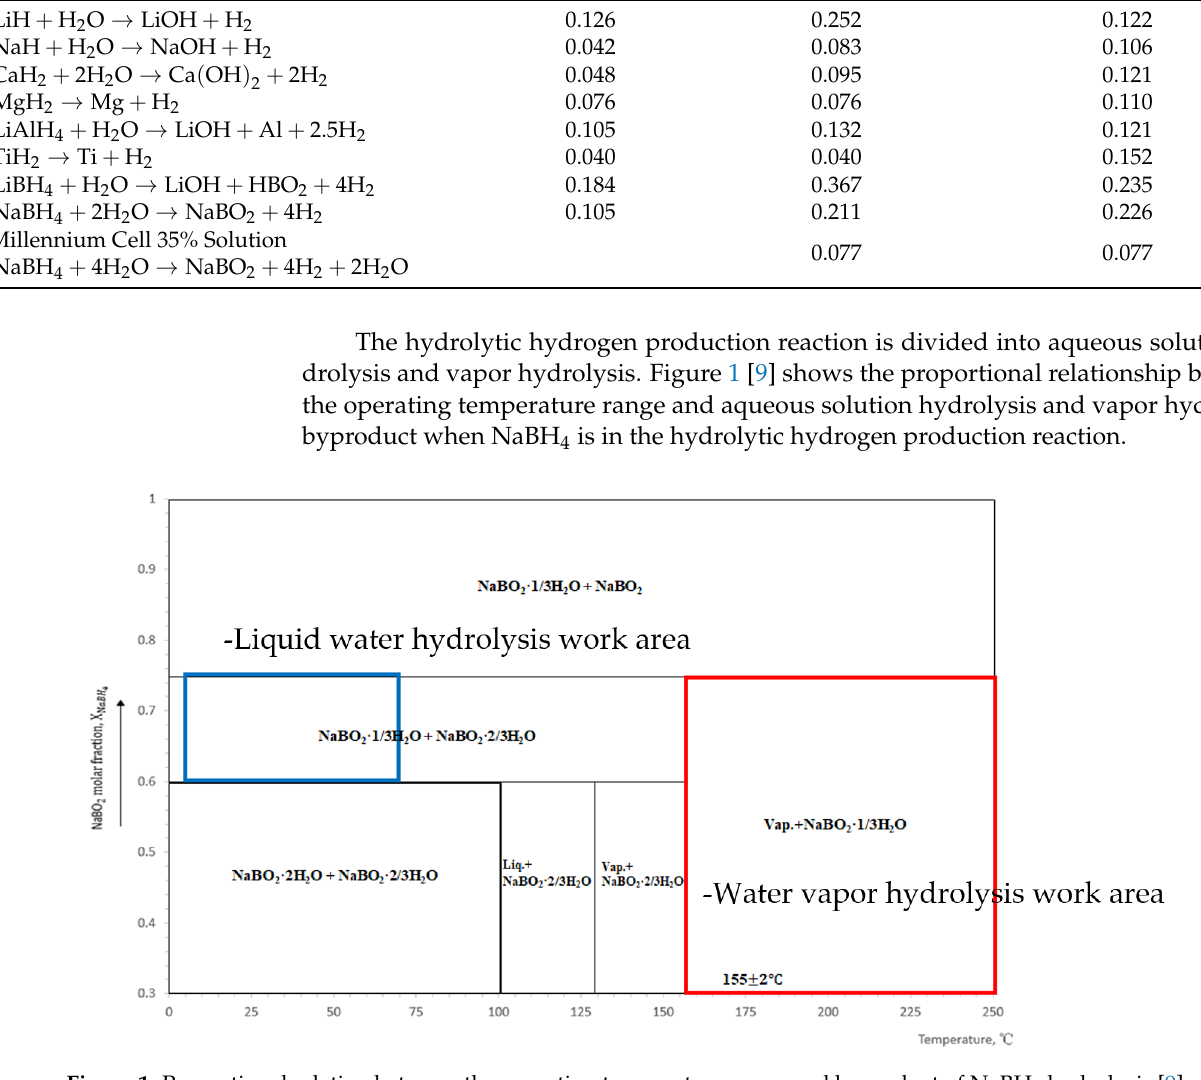
Figure 1. Proportional relation between the operating temperature range and byproduct of NaBH 4 hydrolysis [9]. The NaBH 4 hydrolytic hydrogen production reaction rate is correlated with the pre- pared aqueous NaBH 4 solution and various metal catalysts used. Balba et al. [10] found that the NaBH 4 concentration and temperature, hydrochloric acid, and acetic acid would change the hydrolytic hydrogen production reaction rate, where the hydrogen production rate increased with the acid concentration. Saka et al. [11] found that the phosphoric acid and KBH 4 concentration and temperature influenced the hydrolytic hydrogen production reaction. The addition of 0.25 M or 1 M phosphoric acid could increase the